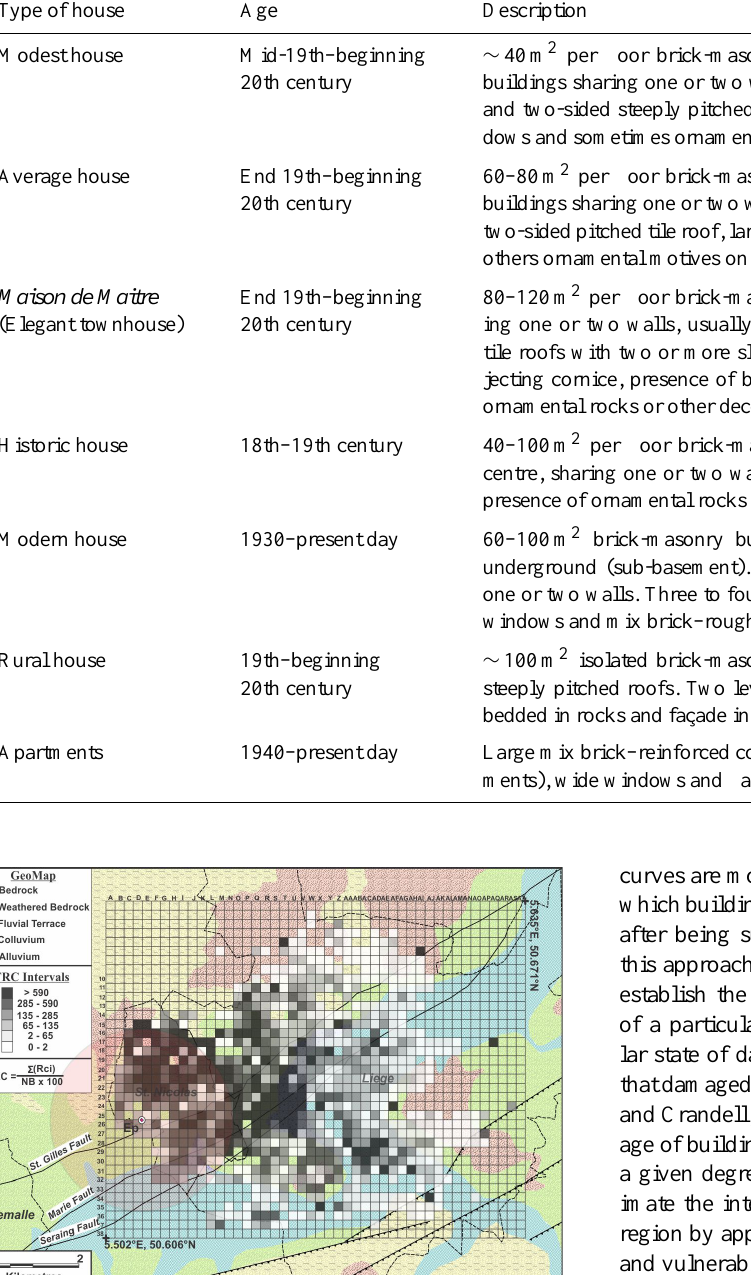
Table 2. Buildings typically found in the region of Li`ege according to Jongmans and Plumier (2000). Type of house Age Description buildings sharing one or two walls, usually presenting two levels (one storey), and two-sided steeply pitched tile roof. Presence of elongated doors and win- dows and sometimes ornamental motives on the fac¸ade.